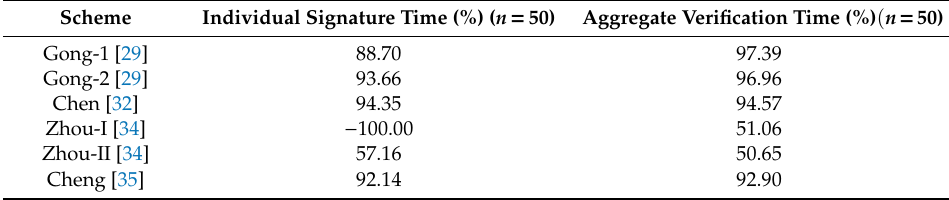
Table 7. The comparison of computational costs with other Table 7 . The comparison of computational costs with other schemes.